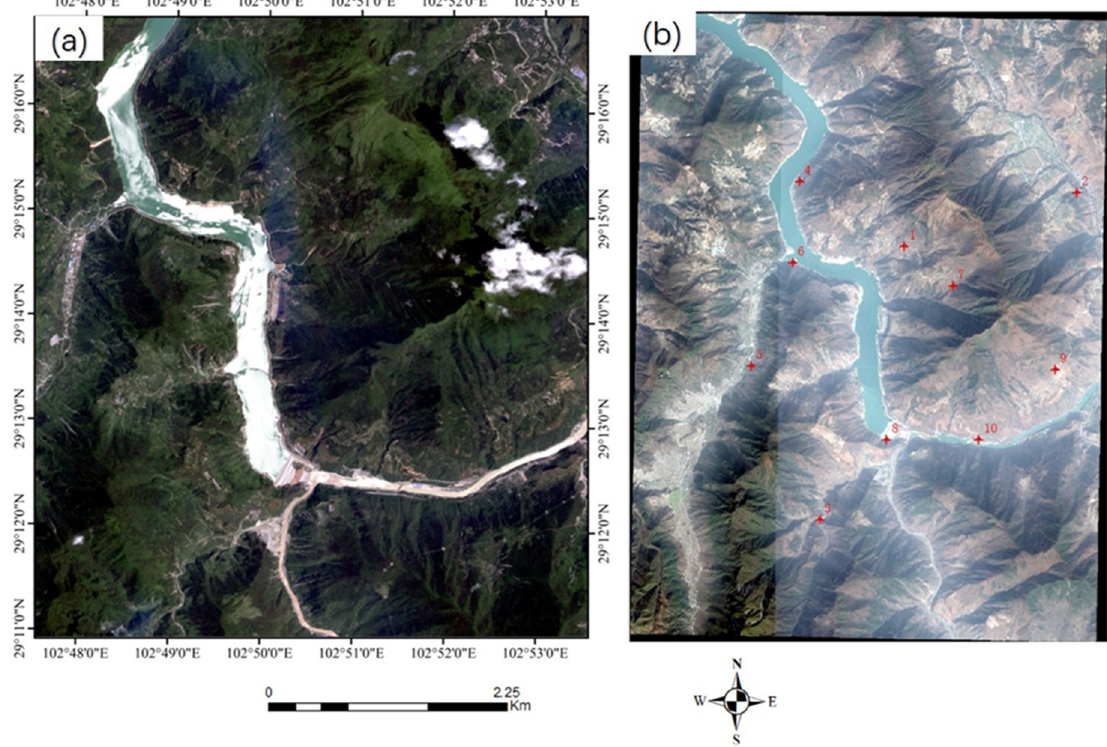
Figure 7. HR multispectral images with disaster of P-D. ( a ) GF-1 image (input image), ( b ) GE image (reference image). Points in red are verification points.